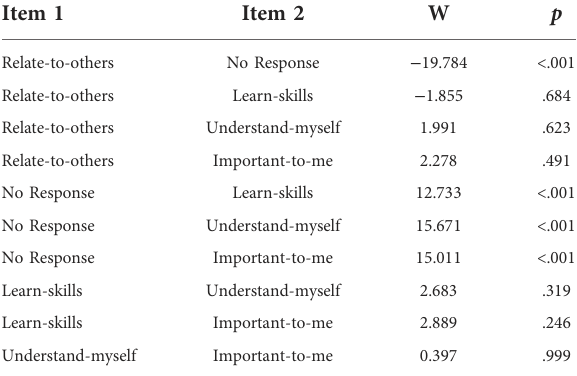
TABLE 8 Dwass-Steel-Critchlow-Fligner pairwise comparisons for domain helpfulness